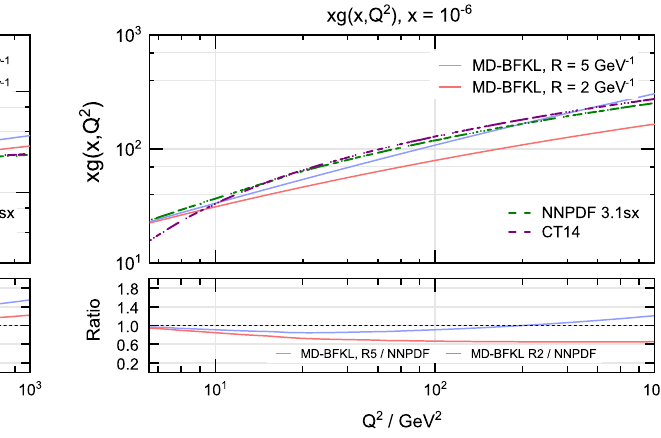
Fig. 4 k 2 evolution of unintegrated gluon distribution f ( x , k 2 T (gluons are distributed throughout the nucleus) and R = 2 GeV − 1 (at “hot-spots” within proton disk). Prediction from modified BK equation is plotted for comparison